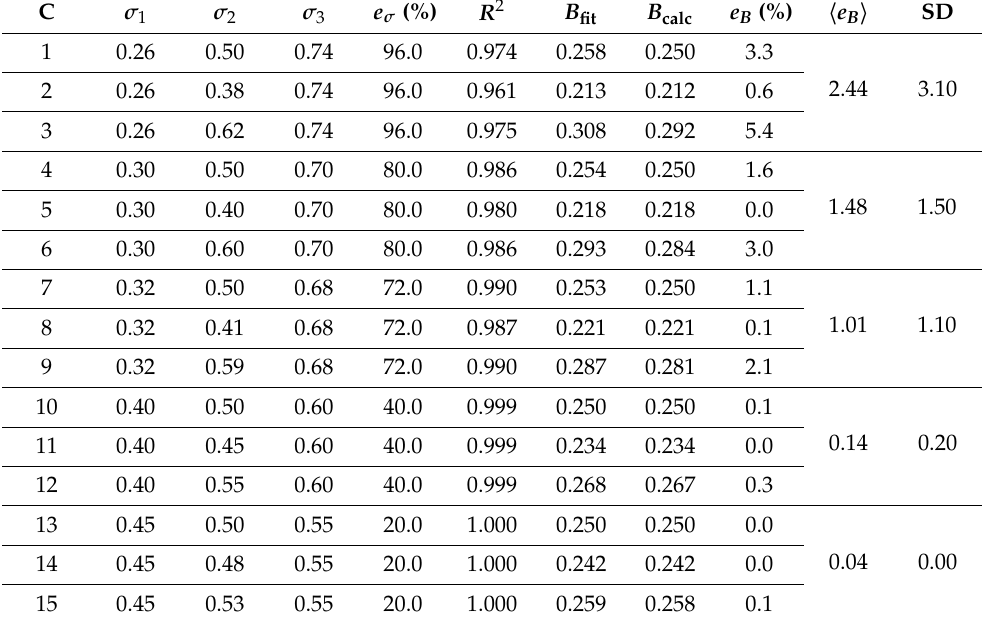
Table 1. Numerical experiments to estimate the accuracy in the calculation of the parameter B . We have generated 10 6 Gaussian-distributed random numbers for each of the three Gaussian distri- butions.